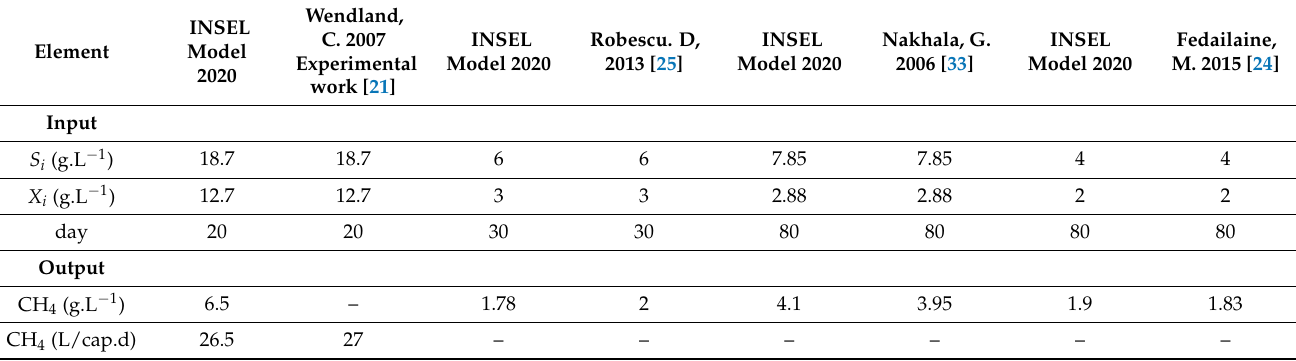
Table 2. Comparison with other models and experimental estimations.